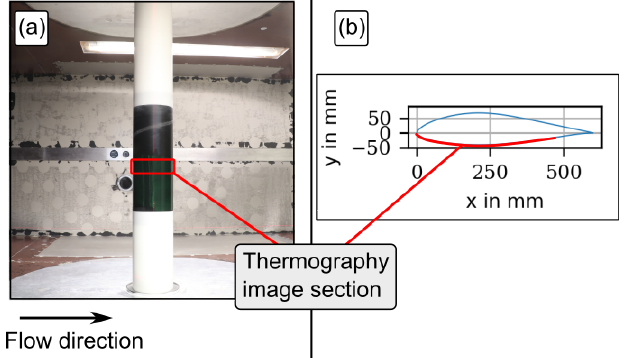
Figure 2. Both measurement objects used in this work. ( a ) DU96W180 airfoil object with a chord length of 600mm. ( b ) Cylinder object with a diameter of 160mm in the wind tunnel test section.